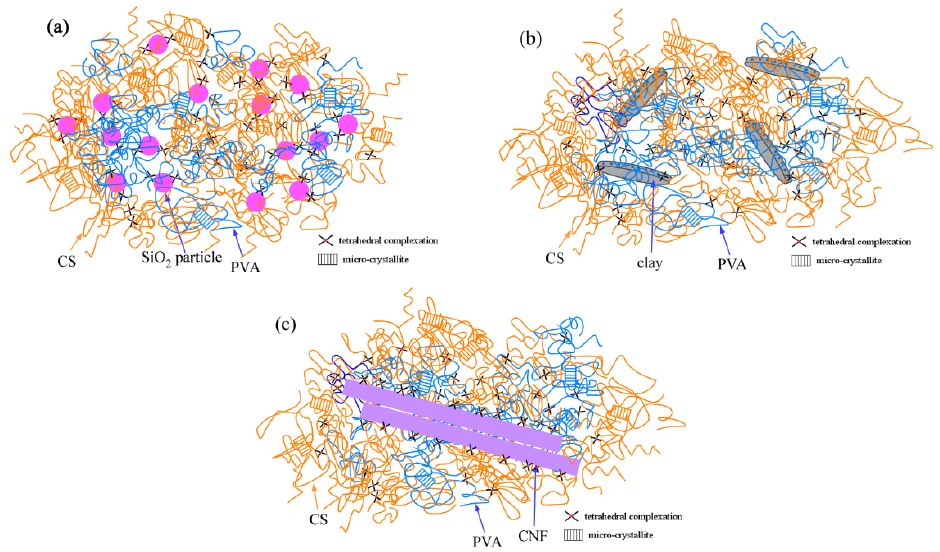
Figure 10. A schematic representation of SiO 2 /CS/PVA/borax ( a ), clay/CS/PVA/borax ( b ), and CNF/CS/PVA/borax ( c ) composite